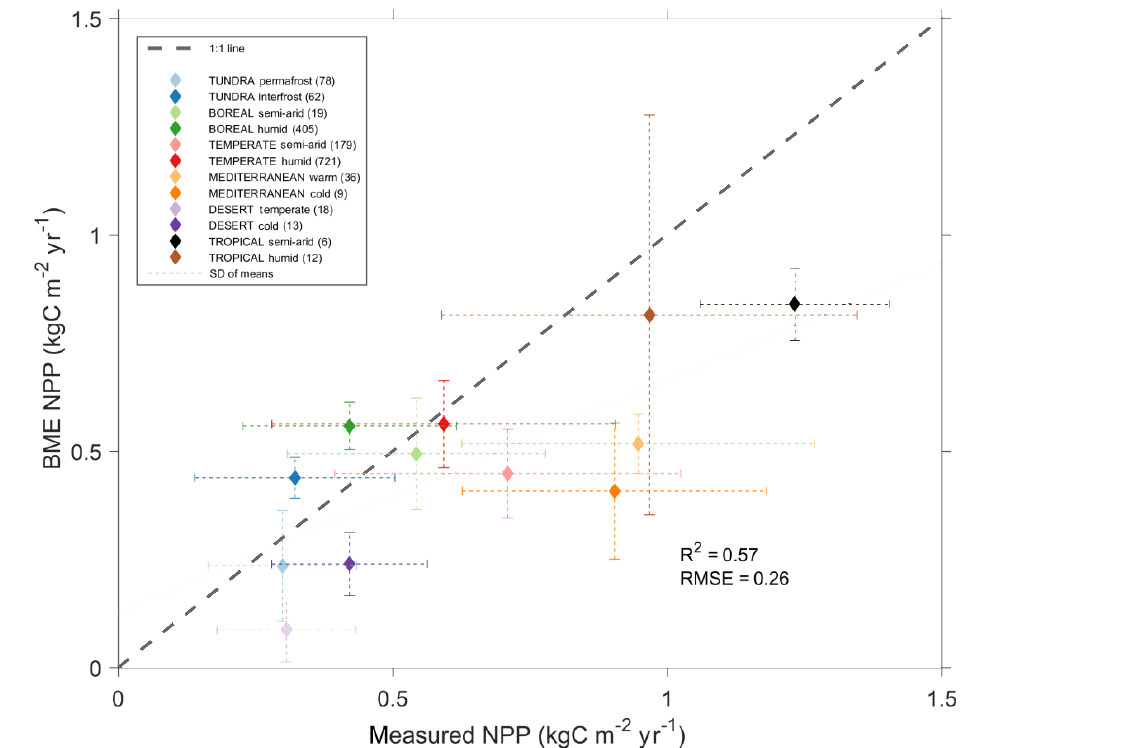
Figure A3. Comparison of BME NPP estimates and NPP field measurements at the biome level using biome mean values and biome standard deviation of the means. The different colours represent MBC biomes based on Reich and Eswaran (2002). The number of NPP observations in each biome is given in the legend. Note the greater Sahel biomes desert temperate, tropical semi-arid, and tropical humid.